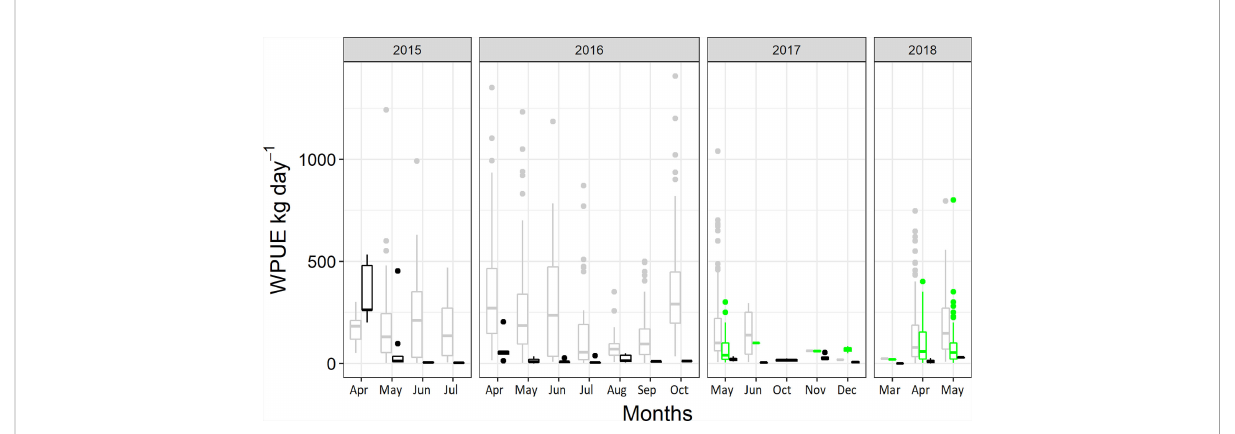
FIGURE 6 Mean catch, WPUE (kg day -1 ), of commercial sized cod (Gadus morhua) in pontoon trap, extrapolated to the potential catch from fi ve simultaneously used traps (black), mean commercial landings from the gillnet fi sheries in the same area (light grey) and seal damaged catch